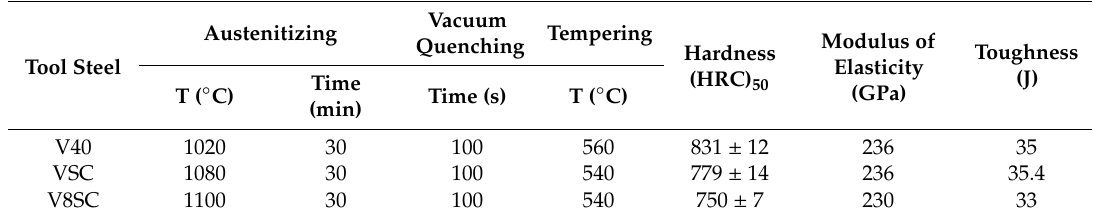
Table 1. The sequence of the heat treatment, modulus of elasticity, toughness, and hardness of the tested tool steels.